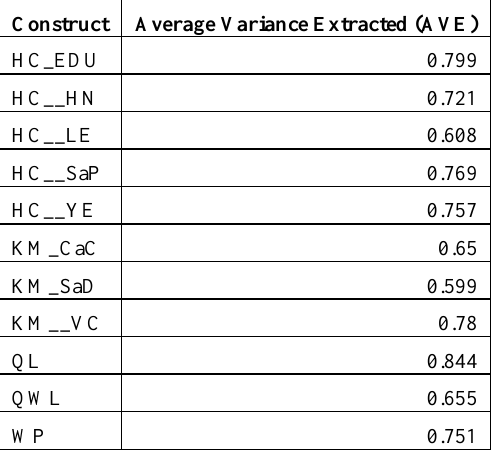
Table 4: Average Variance Extracted